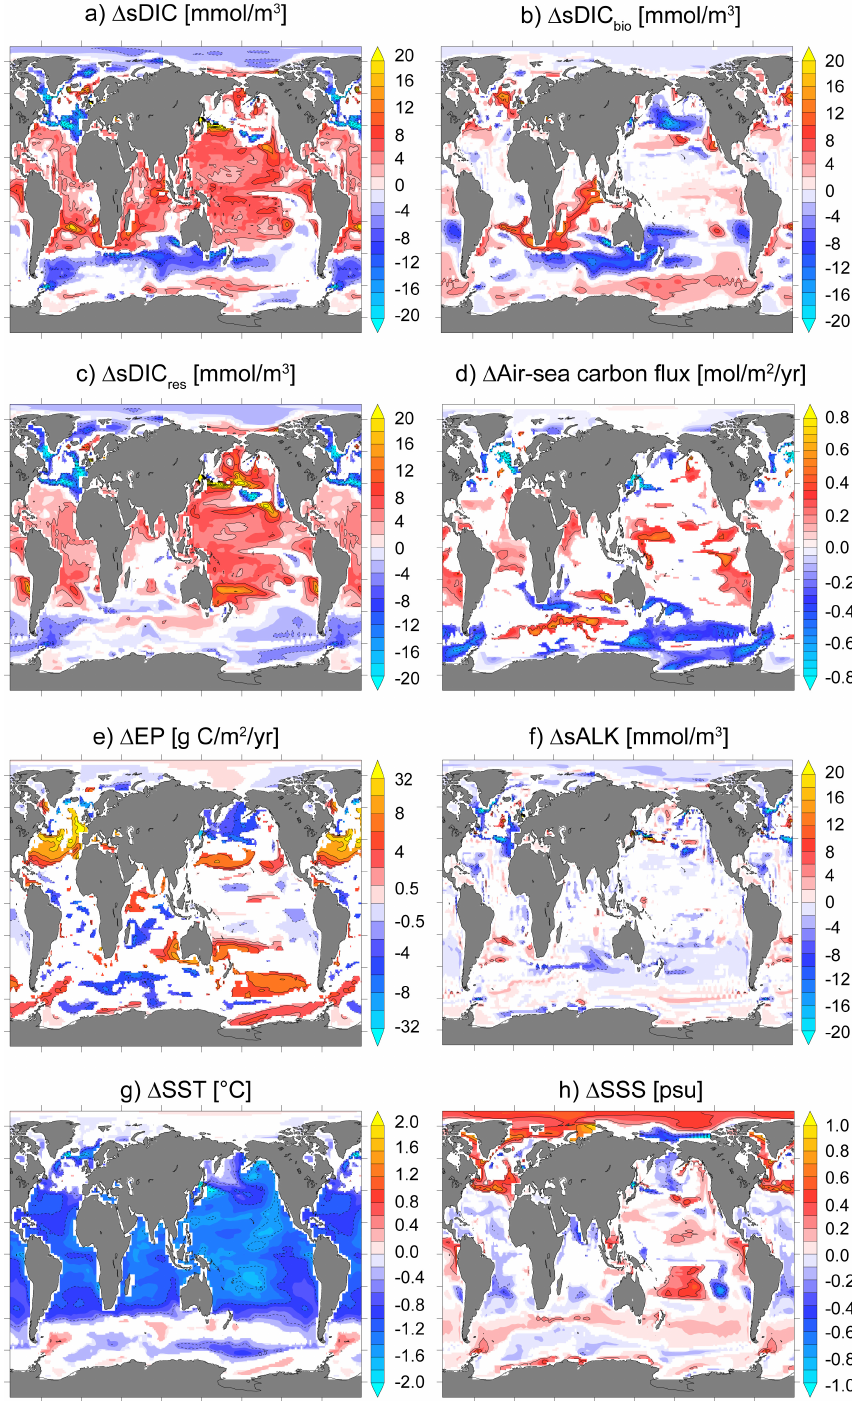
Fig. 8. Difference pattern between the Pin.10x case and the control simulation averaged over the first 5yr: (a) sea surface s DIC, (b) sea surface s DIC changes due to the internal reorganization of the organic matter cycle and CaCO 3 cycle ( s DIC bio ), (c) the residual s DIC ( s DIC res = s DIC– 1s DIC bio ), (d) air-sea carbon flux, (e) export production of particulate organic carbon, (f) sALK, (g) sea surface tem- perature and (h) sea surface salinity. Only grid cells are shown where the magnitude of changes are significant at the 5% level based on a two-sided Student’s t-test. The changes for export production are shown on an exponential